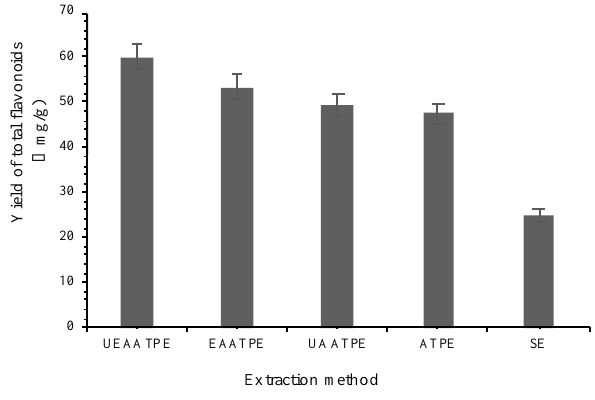
Figure 3. Effects of different methods on the yield of total flavonoids.